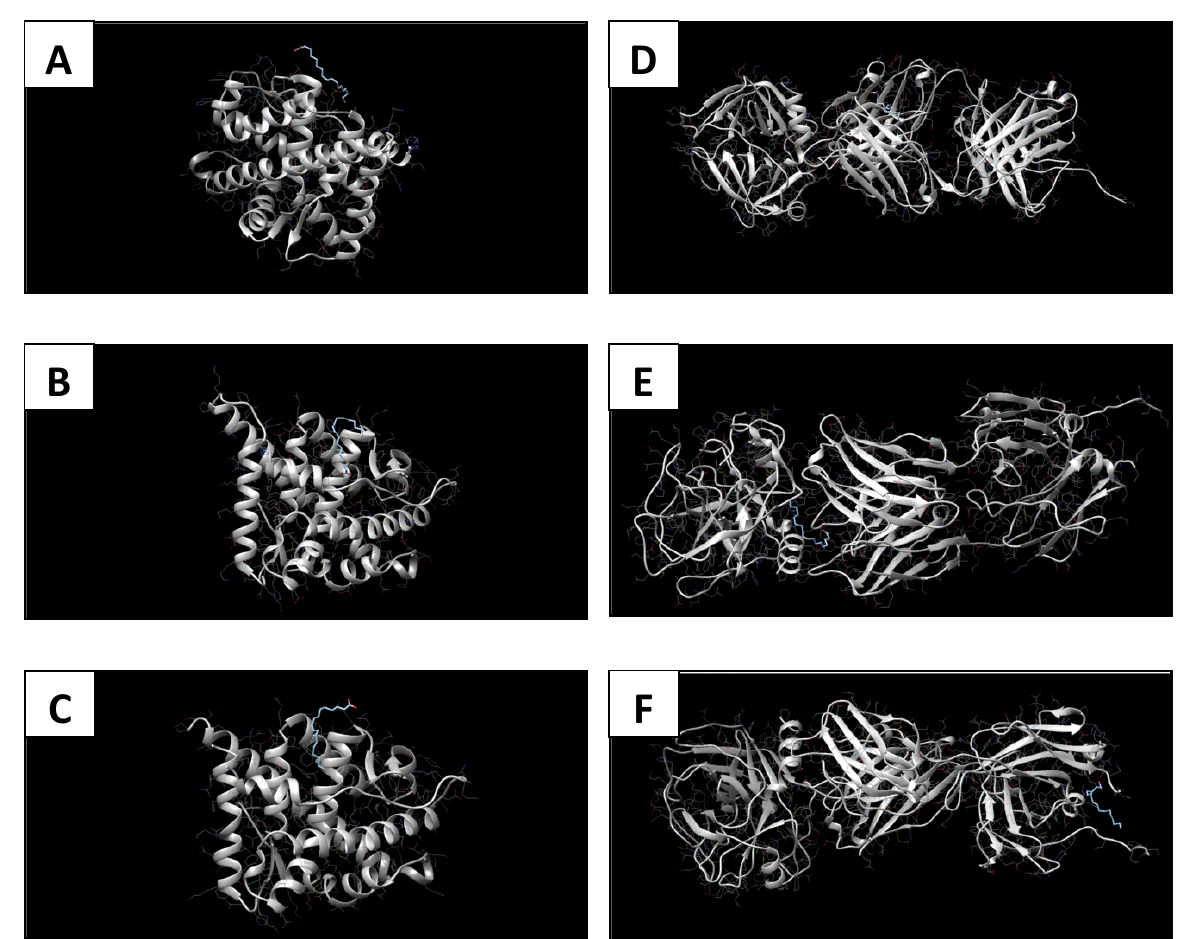
Figure 5. Molecular docking of oleic acid with androgen receptor (AR) PDB codes: 3RLJ (A), 5T8J (B), 5VO4 (C), and protein specific antigen (PSA) PDB codes: 2ZCH (D), 2ZCK (E), 2ZCL